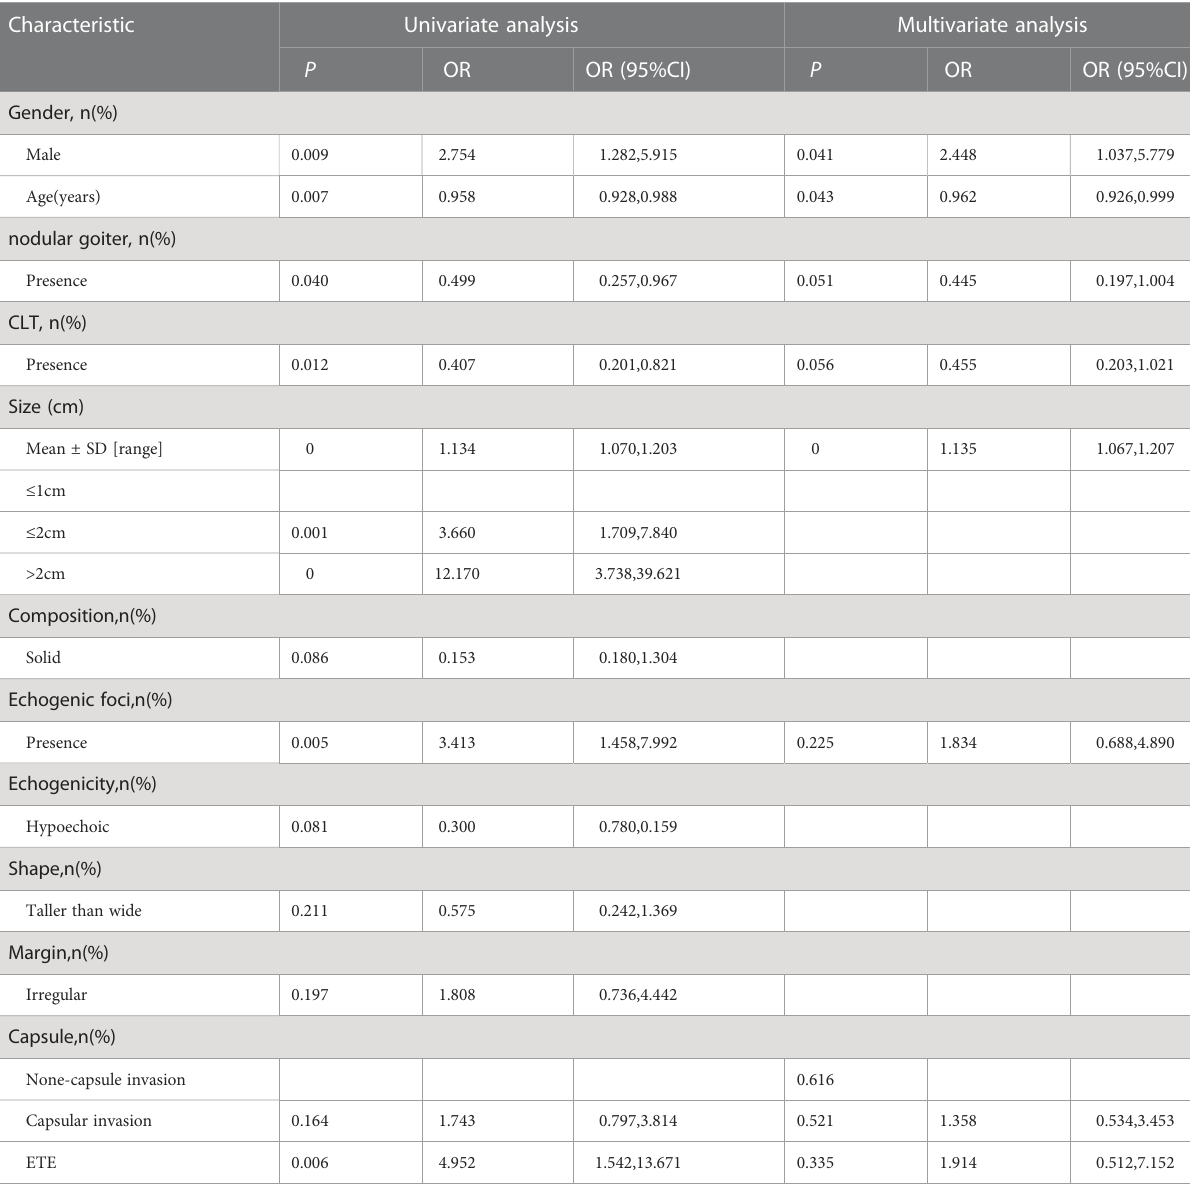
TABLE 3 Univariate analysis and multivariate analysis of factors associated with ipsilateral central lymph node metastasis (CLNM) in patients with isthmus papillary thyroid carcinoma (PTC). Characteristic Univariate